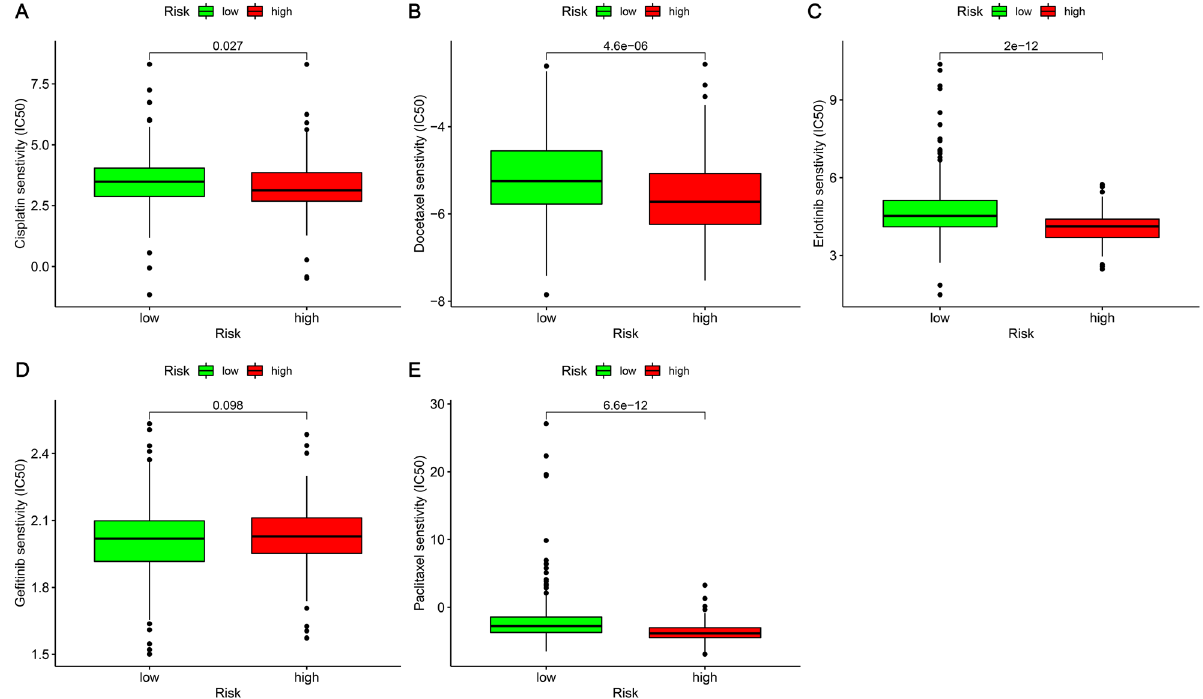
Figure 10. The relationship between LUAD patients’ chemotherapeutic agents and risk model. In comparison to the low-risk group, the high-risk group was correlated to a higher sensitivity to ( A ) Cisplatin; ( B ) Docetaxel; ( C ) Erlotinib; ( E ) Paclitaxel. However, ( D ) Gefitinib was not significantly different between the two